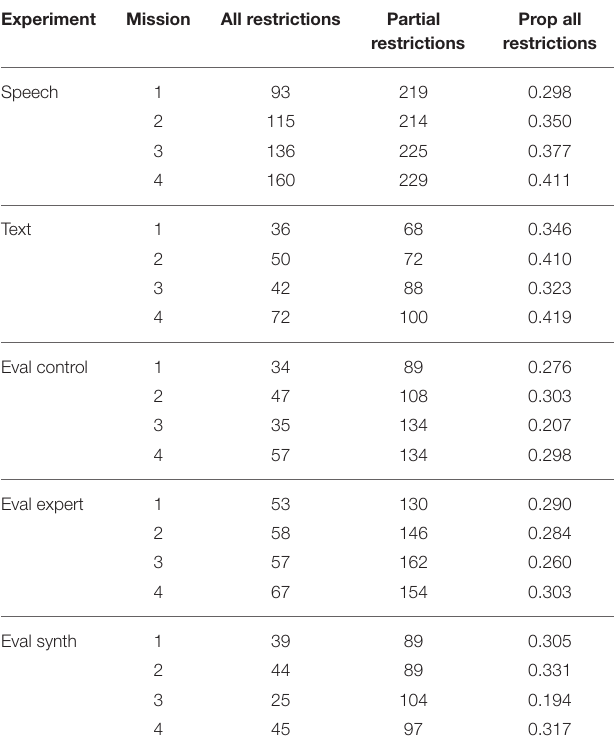
TABLE 4 | Total counts of communications broken down by whether the waypoint being mentioned required all restrictions or only some.